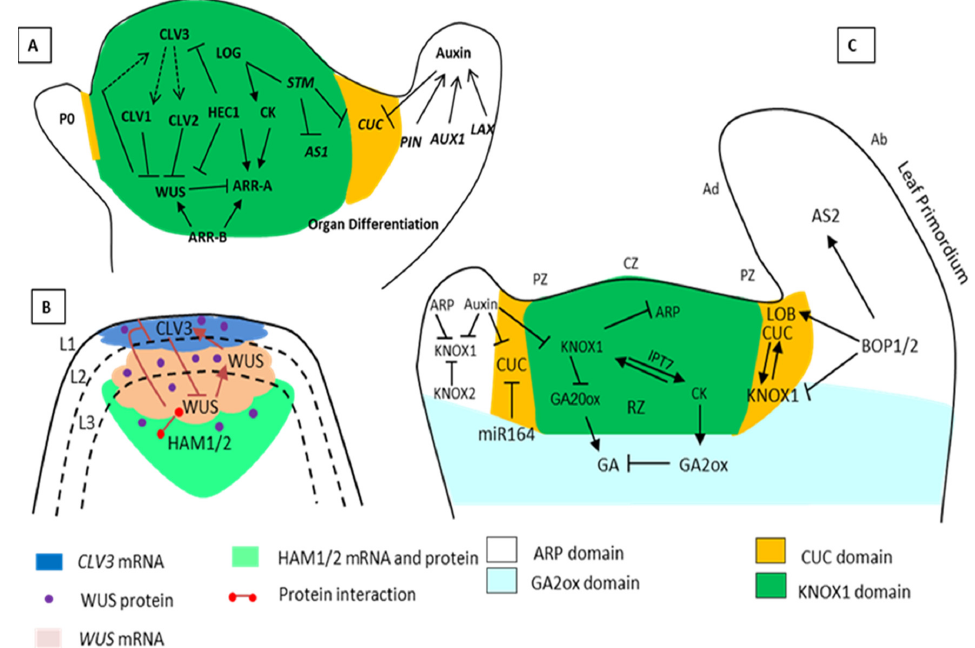
Figure 1. Schematic representation of Shoot Apical Meristems (SAM) maintenance by the various interacting genes. ( A ) The pluripotent stage and a specific number of cells in the SAM are controlled by the (WUS / CLV3) negative-feedback loop. CLAVATA3 (CLV3) is a ligand attached to CLV1 and CLV2 for the restriction of WUS. However, WUS activates CLV3 and works as a stem cell-promoting protein. STM activated the biosynthesis of CK through LONELY GUY (LOG). The STM and KNOX related genes also keep the stem cells undifferentiated by suppressing the expression of AS1 and gibberellic acid (GA) biosynthesis. STM also restricts the expression of the CUC gene due to negative regulators in a specific area. ( B ) The HAM and WUS-CLV3 loop. The regulatory loop requires CLV3, WUS, and HAM; the CLV3 negatively regulates the WUS expression, and the WUS protein moves from the organizing center to the active central zone (stem cells) to activate CLV3 expression. HAM1 / 2 is an interacting partner of WUS, and together with WUS protein suppresses the expression of CLV3 in the rib meristems. The expression zone of the CLV3 gene (blue), WUS gene (pink), HAM proteins (green) and the dot marks the WUS protein. ( C ) Regulatory networks that control leaf initiation. The cells in the SAM are arranged into layers L1, L2, and L3 and further into a distinct group of either tunica or corpus. According to the expression of genes, the SAM architecture is organized with the central zone (CZ), peripheral zone (PZ), organizing zone (OZ), and rib zone (RZ). During leaf initiation, auxin maxima repress the expression of the KNOX1 domains (gene) indeterminate meristem domains. KNOX1 maintains a high level of CK and low levels of GA in the meristem. In the ARP domain that has leaf identity, the leaf primordium separates from SAM by expression of boundary specific genes CUC and BOP regulates the petiole specification and polarity (positive and negative regulations are indicated by pointed and T-shaped